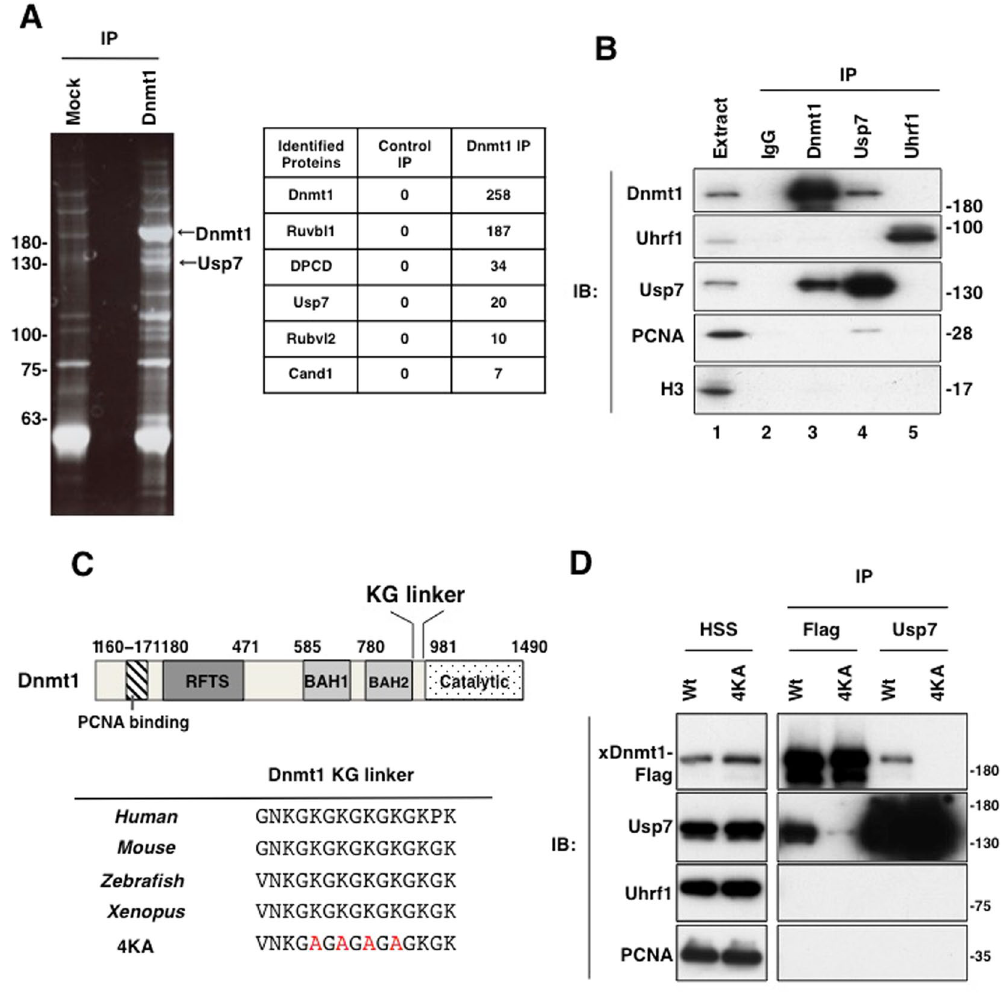
Figure 2. Usp7 forms a stable complex with Dnmt1 in Xenopus egg extracts. ( A ) Dnmt1 was immunoprecipitated from interphase HSS using specific antibodies. The associated polypeptides were identified by mass spectrometry. The resultant immunoprecipitates were subjected to SDS-PAGE and stained with a SyproRuby; the peptides corresponding to Dnmt1 and Usp7 are indicated. The numbers of unique spectra identified for each protein are shown in the table. ( B ) Immunoprecipitates using anti-Dnmt1 (lane 3), anti-Usp7 (lane 4), anti-Uhrf1 (lane 5) antibodies, or control IgG (lane 2) as well as egg extracts (lane 1) were subjected to immunoblotting using the antibodies indicated. ( C ) Sequence alignment of the KG linker of Dnmt1 across different species. Red denotes residues mutated in a 4KA mutant used in this study. ( D ) FLAG-tagged wild- type or a 4KA mutant of recombinant Xenopus Dnmt1 was introduced into Xenopus egg extracts. Recombinant or endogenous Usp7 was immunoprecipitated using either anti-FLAG-M2 agarose beads or protein A agarose beads conjugated with anti-Usp7 antibodies, respectively. Immunoprecipitates were then subjected to immunoblotting using the antibodies indicated. Source data are available online for this